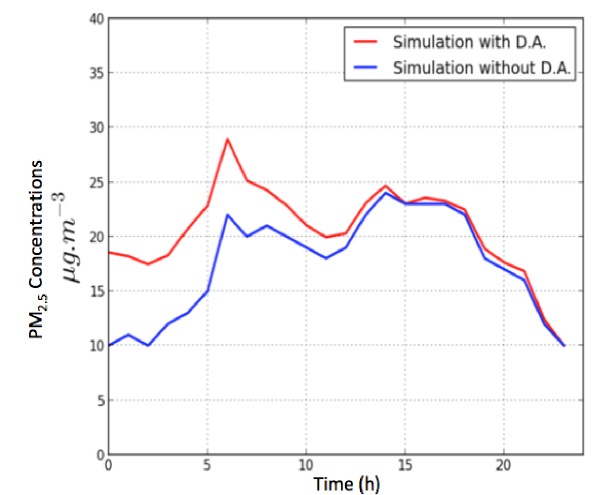
Figure 7. Daily profile of PM 2.5 concentrations averaged temporally over the one-month simulation period and on cells on which the PM 2.5 relative difference is higher than